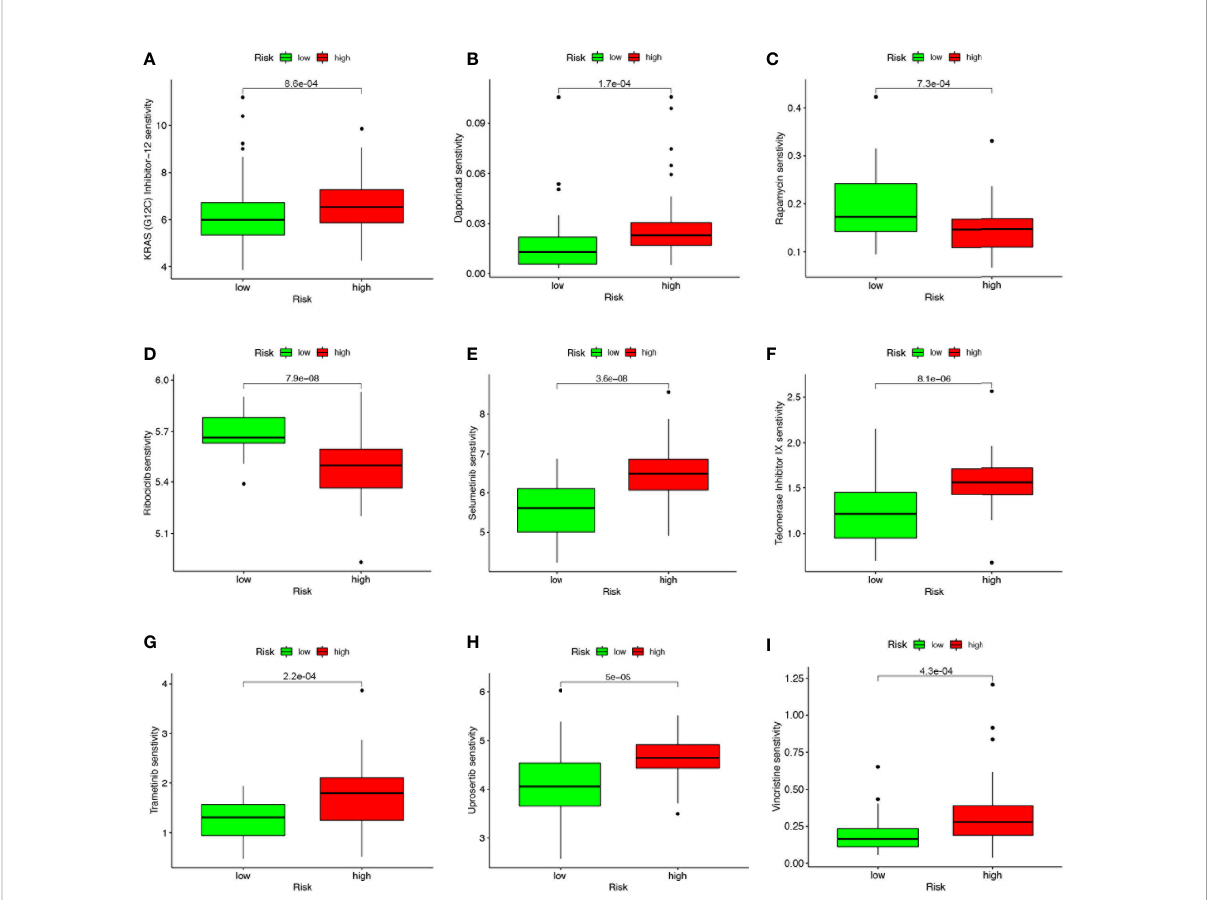
FIGURE 8 4-SMGs signature predicts chemotherapy sensitivity. (A) KRAS (G12C) Inhibitor-12, (B) Daporinad, (C) Rapamycin, (D) Rapamycin, (E) Selumetinib, (F) Telomerase Inhibitor IX, (G) Trametinib, (H) Uprosertib and (I)